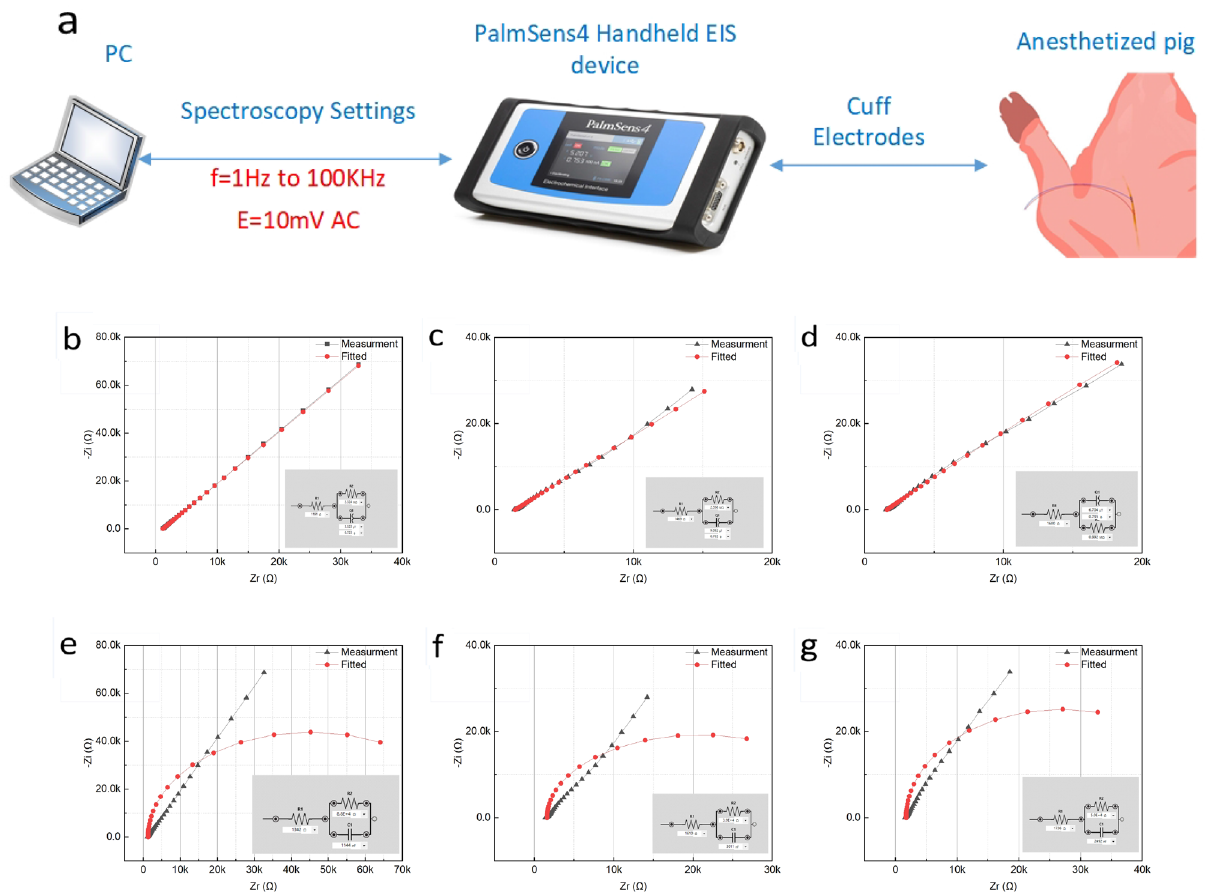
Figure 4. Presentation of EIS for connection verification and load calculation. ( a ) EIS measurement setup along for the 1 Hz to 100 kHz range using a 10 mV AC signal. ( b–d ) Nyquist plots of the impedance of tissue and fitted circuit using CPE and two resistors for circuit fitting. ( e–g ) Nyquist plots of the impedance of tissue and fitted circuit using a capacitor and two resistors for circuit